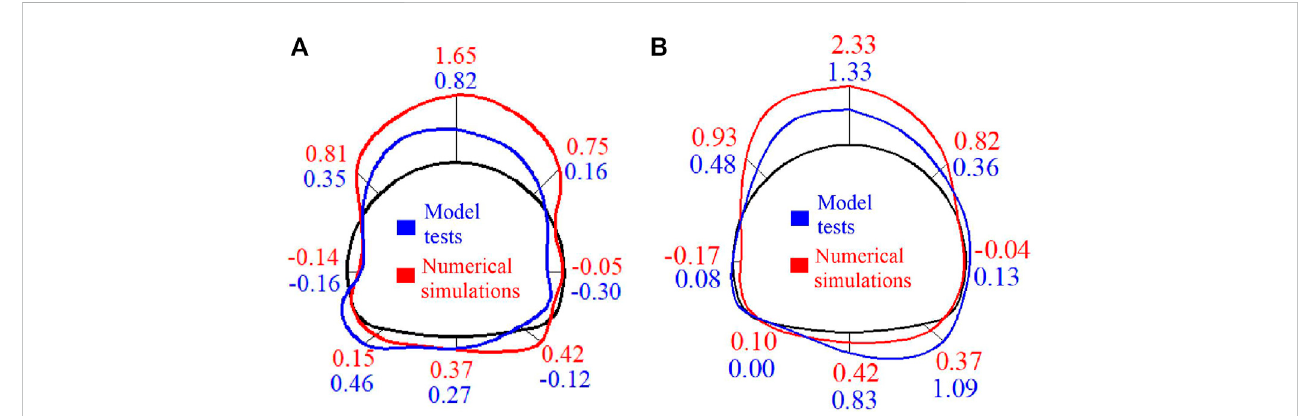
FIGURE 14 Firstprincipalstressofliningstructureinnumericalsimulationsandmodeltests(unit:MPa): (A) Stressoutsidetheliningstructureand (B) Stressinsidethe lining structure.